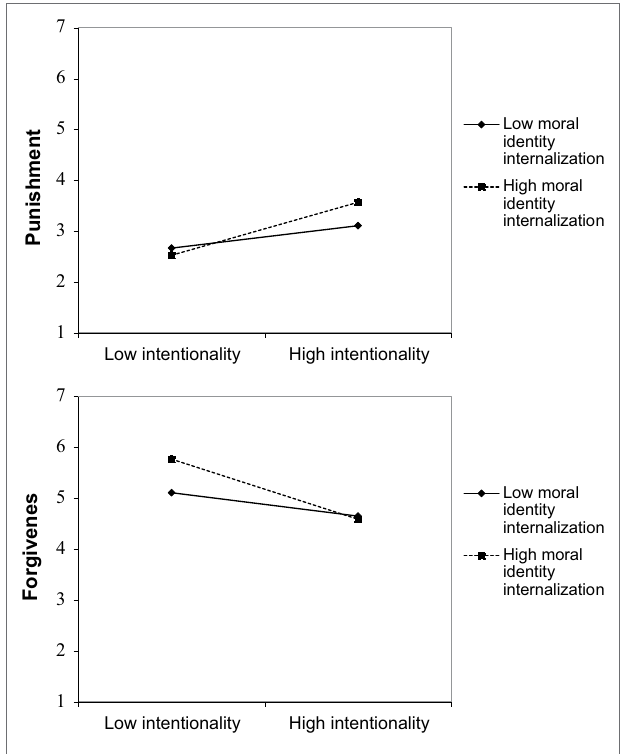
FIGURE 2 | Interaction between moral identity salience and transgression intentionality on punishment (top panel) and forgiveness (lower panel) in Study